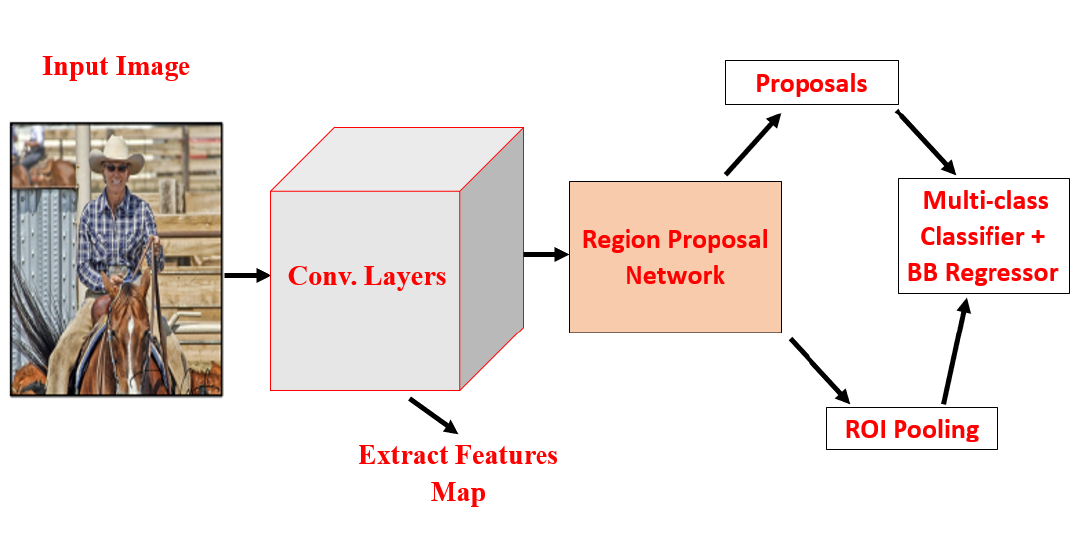
Figure 7. Faster RCNN architecture [2].